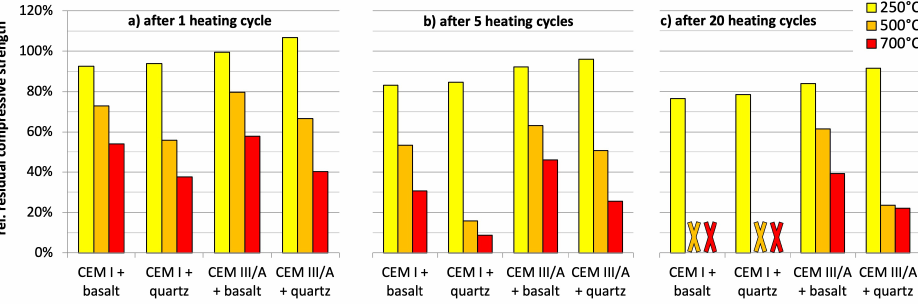
Figure 2. Residual compressive strength after 1 heating cycle (a), 5 heating cycles (b) and 20 heating cycles (c). Crosses (X) denote untestable mixtures due to complete